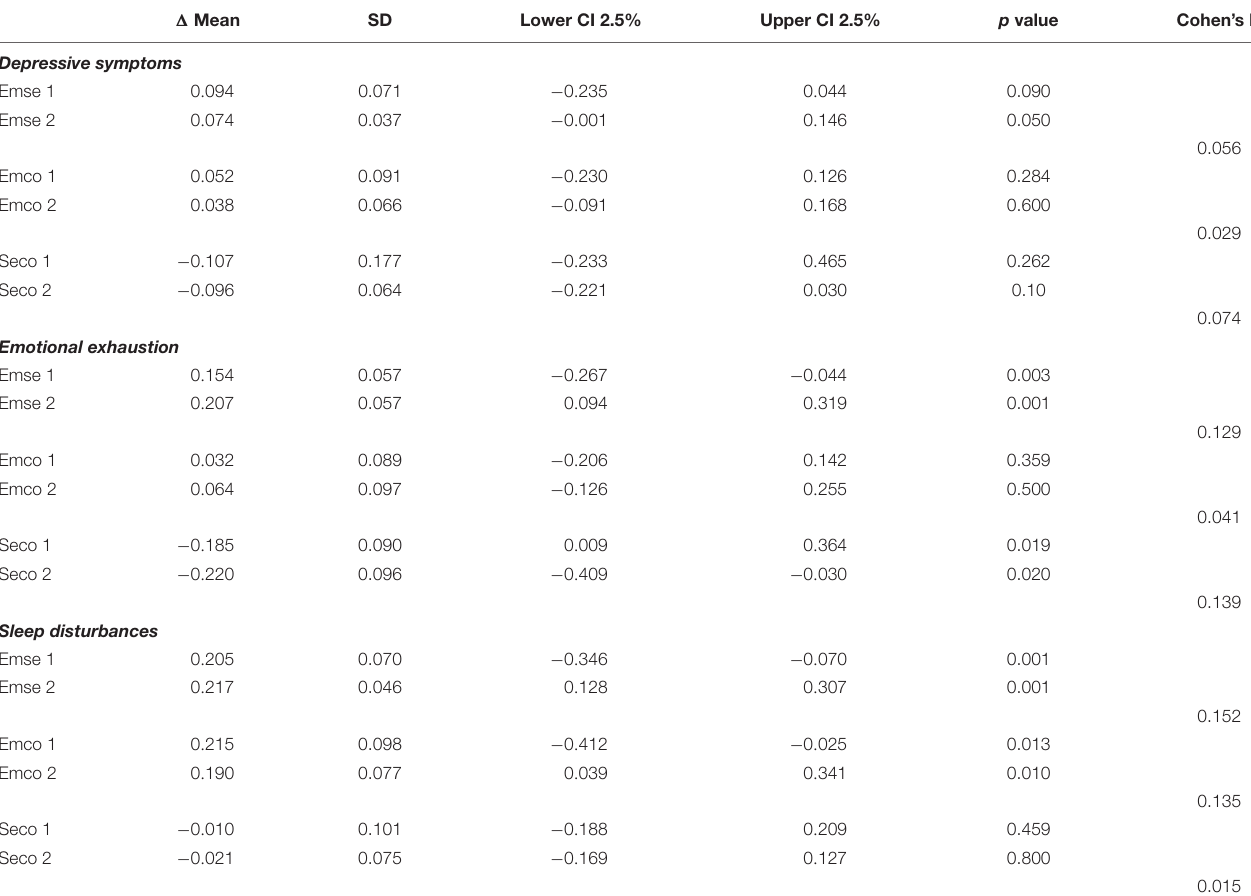
TABLE 7 | Depressive symptoms, emotional exhaustion, and sleep disturbances in employed (EM) and self-employed workers (SE) and combinators (CO). (cid:49) Mean SD Lower CI